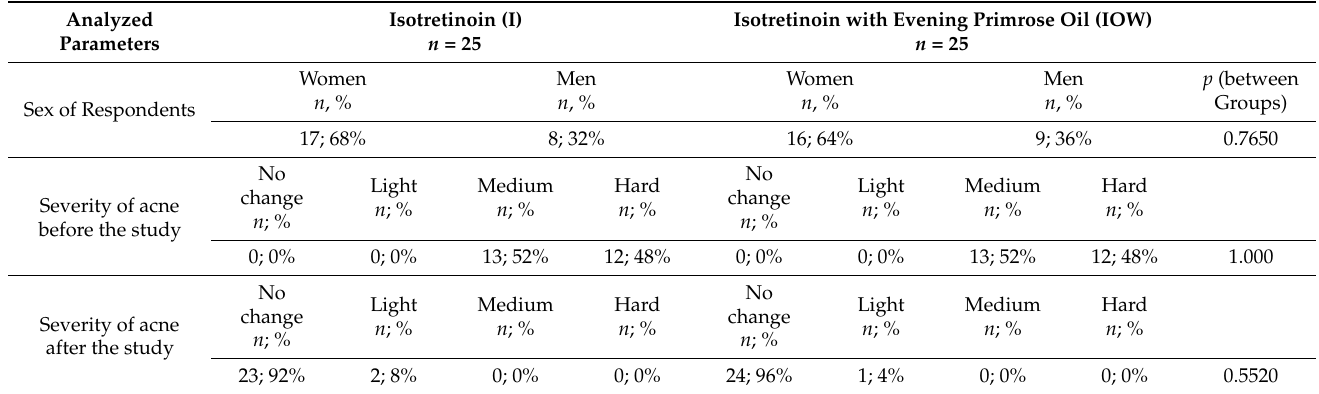
Table 1. Sex of study participants and severity of acne before and after the study.